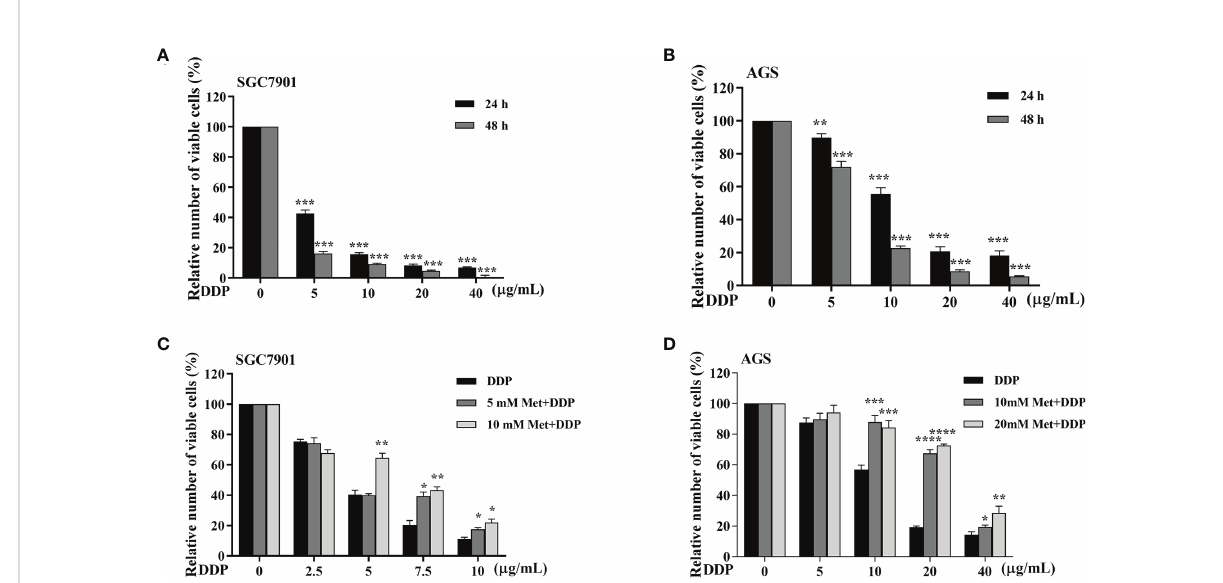
FIGURE 2 Metformin alleviates cisplatin-induced growth inhibition in GC cells. (A, B) SGC-7901 and AGS cells were treated with cisplatin for 24 or 48 h, followed by CCK8 assay. (C, D) SGC-7901 and AGS cells were pre-treated with metformin for 4 h followed with cisplatin treatment for 24 h. Cell viability was determined by CCK8 assay. Data were presented as the means ± SD. The experiments were repeated three times independently. * p <0.05, ** p <0.01, *** p <0.001,